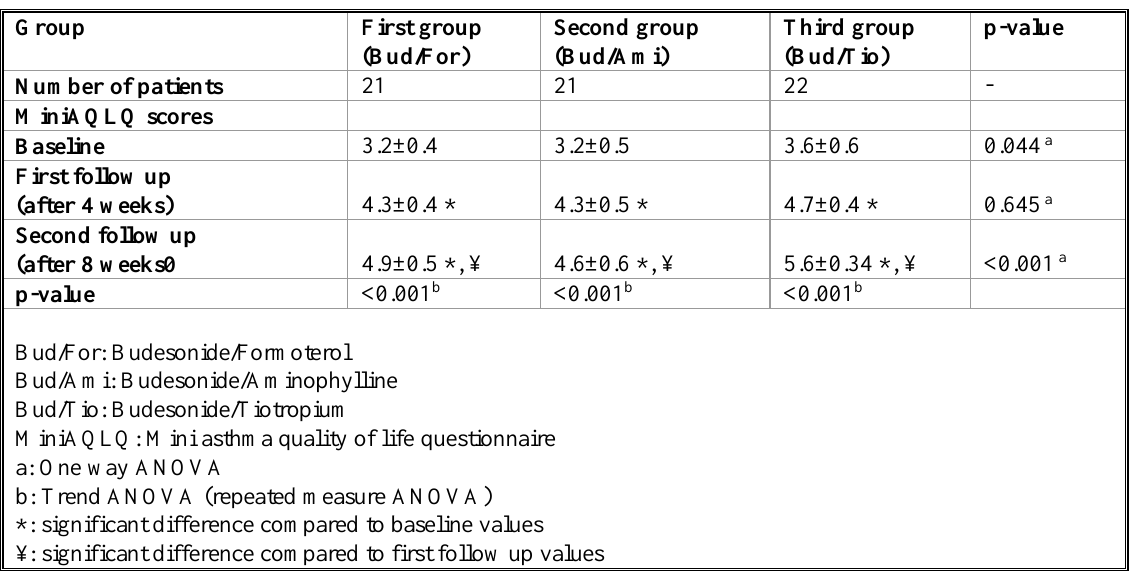
(p=0.645) as explained in figure 7.